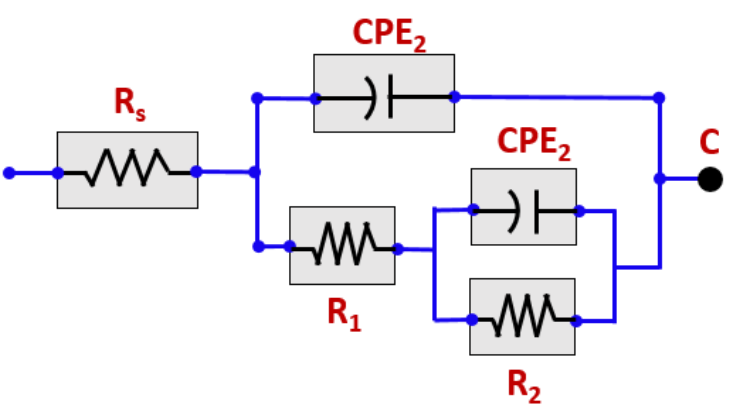
Figure 4. Equivalent circuit diagram for EIS fitting.